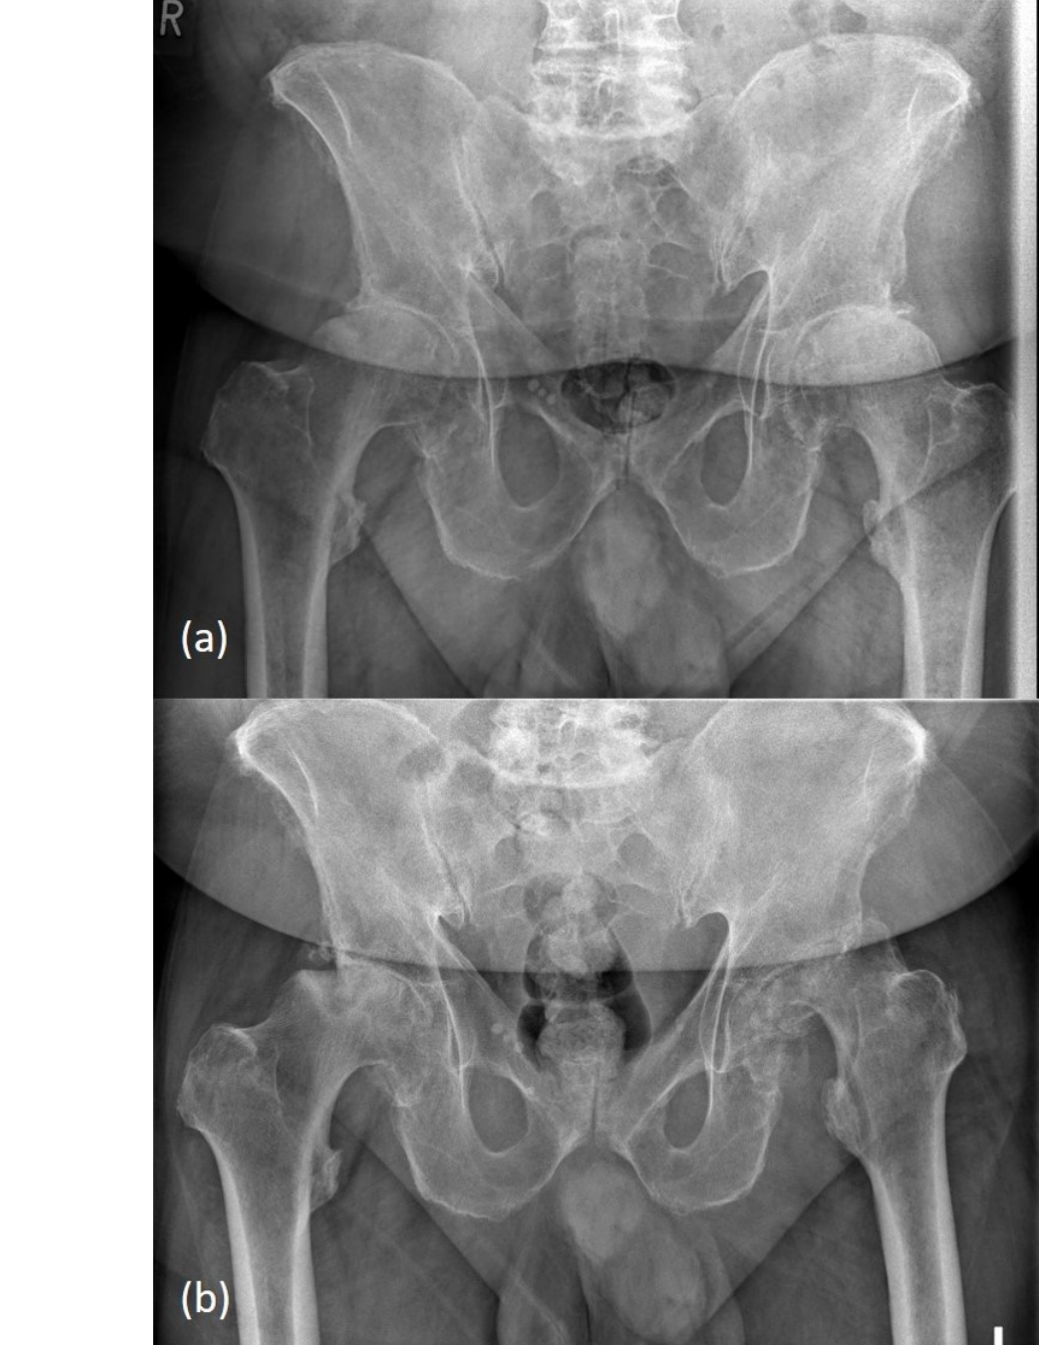
Figure 1. Copyright is held by the Regensburg University Medical Center. (a) X-ray of the pelvis showing advanced osteoarthritis of both hip joints. (b) X-ray of the pelvis showing femoral head necrosis on both sides with extensive osteolysis of both femoral heads and bone loss of the acetabular rim on the left